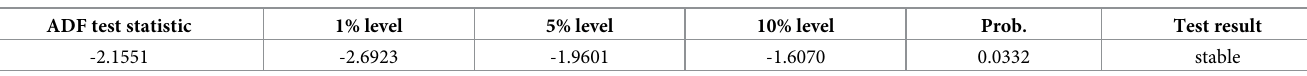
Table 6. ADF test results for external R&D residuals.